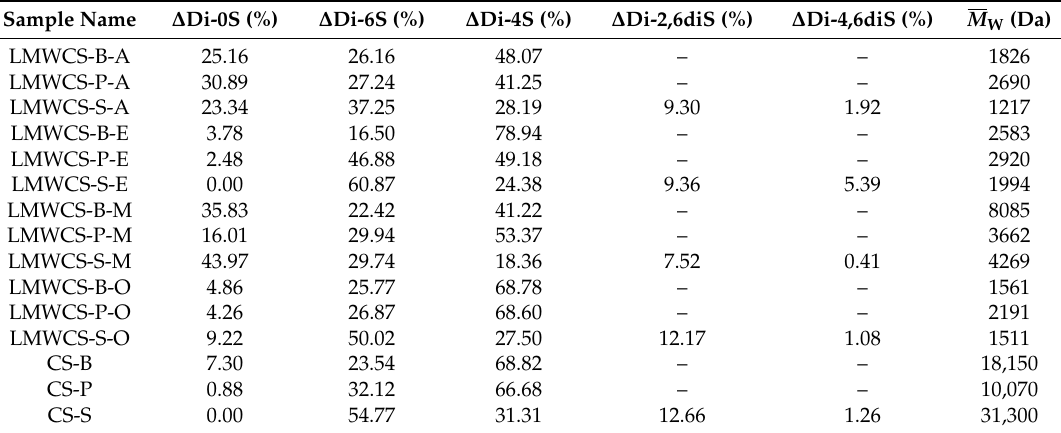
Figure 1. Characterization of low molecular weight chondroitin sulfate (LMWCS) samples. ( A ) Disaccharide compositions of all CS samples from three sources depolymerized by different methods. B, P and S stand for bovine, porcine and shark cartilage, respectively. A stands for the HCl method; E stands for enzymatic method; M stands for microwave-assisted alkaline method; and O stands for oxidative method. a, ∆ Di-0S; b, ∆ Di-6S; c, ∆ Di-4S; d, ∆ Di-2,6diS; e, ∆ Di-4,6diS; ( B ) UV spectra of all CS samples; ( C ) Proton nuclear magnetic resonance ( 1 H-NMR) spectra of chondroitin sulfates (CSs) from three sources and low molecular weight chondroitin sulfates (LMWCSs) depolymerized by different methods. Table 1. Disaccharide compositions and M W of all samples.